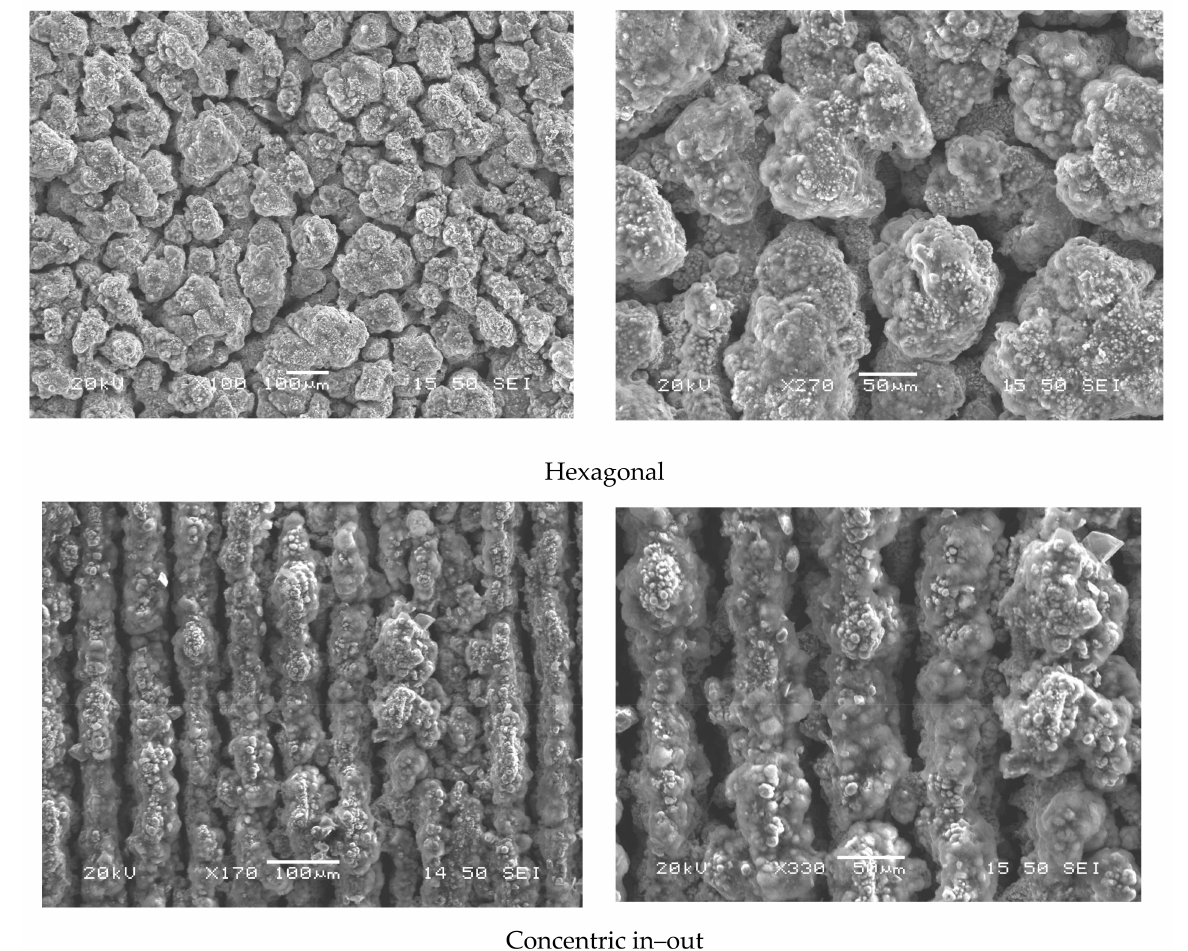
Figure 14. SEM images for SiC samples printed using different scanning